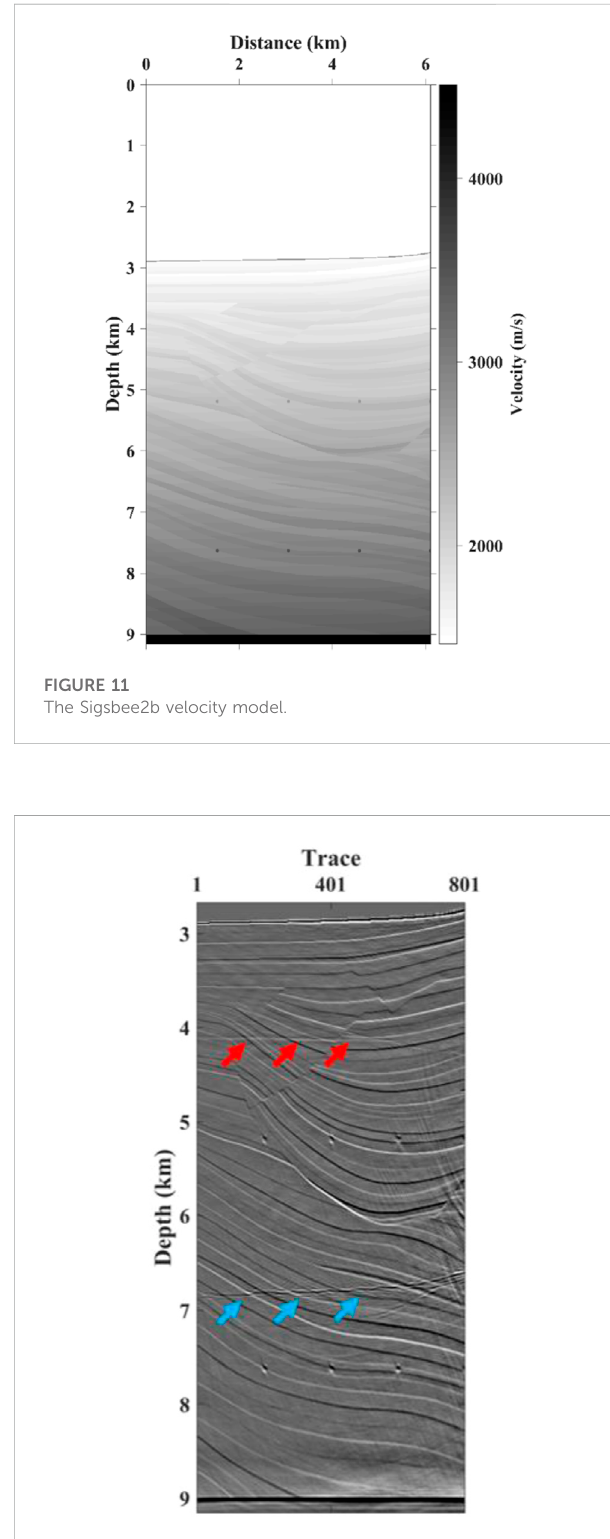
FIGURE 12 The imaging results of migration. The red arrows and light blue arrows mark the locations of anti-causal crosstalk and causal crosstalk,